Question: Give a one-sentence summary of this figure.
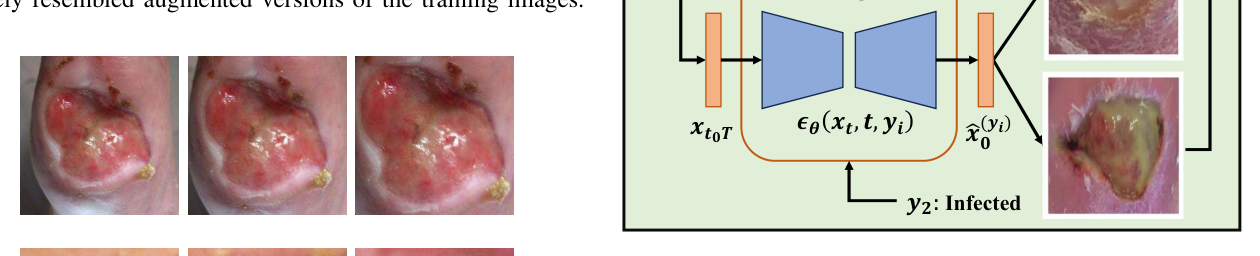
Answer: Inference in the ConDiff Classier Framework. Input x0 is perturbed by noise of strength t0. The perturbed input xt0T is denoised through a reverse diffusion process to synthesize image ˆx(yi) 0 condi- tioned on label yi. Infection classification is based on the minimum L2 distance between x0 and ˆx(yi) 0 in embedding space.